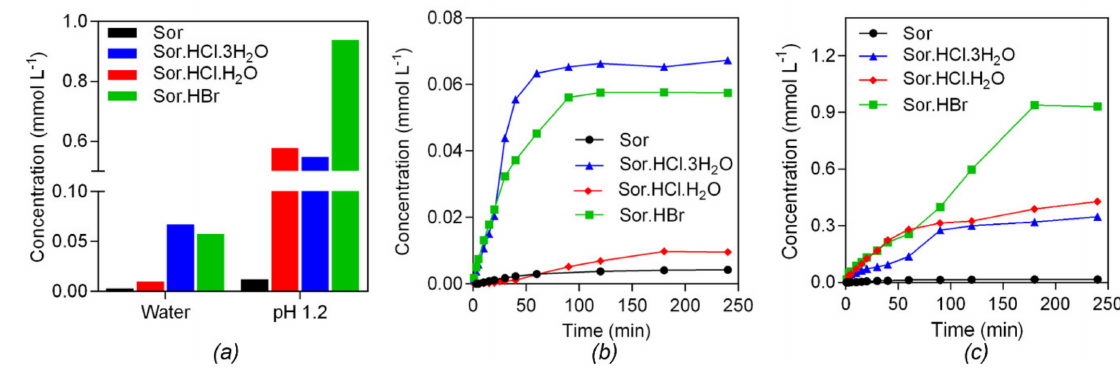
Figure 9. ( a ) Solubility and dissolution rate of (I), (II), (IV) and Sor in ( b ) water and ( c ) pH 1.2